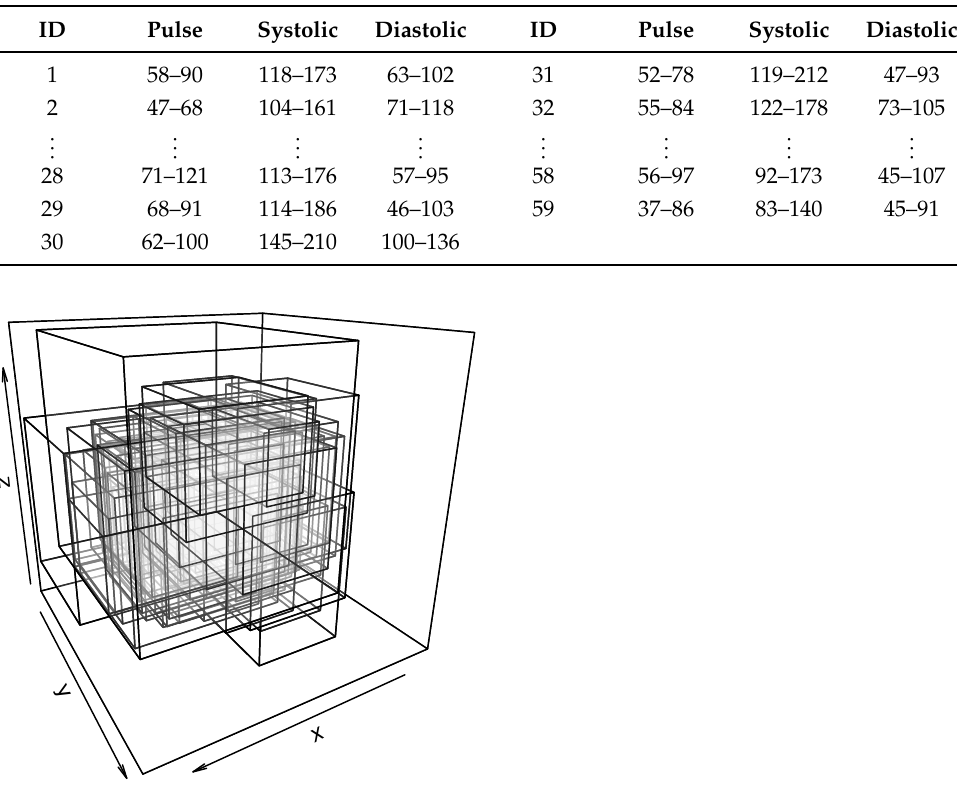
Figure 1. Representation of the cardiology three-dimensional cuboid dataset. The x-axes represent, for each patient, the range of the blood pulse over a same day, the y-axes the range of the systolic blood pressure over the same day, and the z-axes the range of the diastolic blood pressure over the same day. There are a total of 59 patients, with one cuboid per